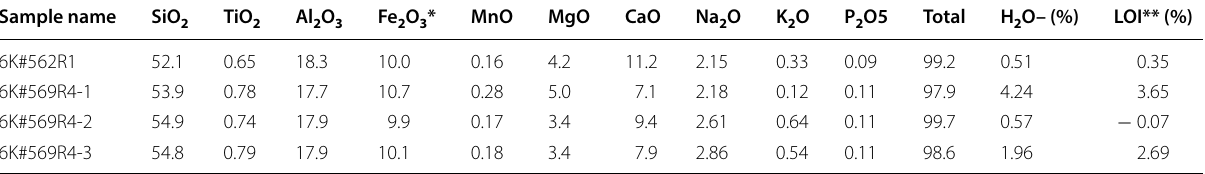
Table 2 Whole‑rock geochemistry of the studied volcanic rock samples from the Irabu knolls of the Okinawa